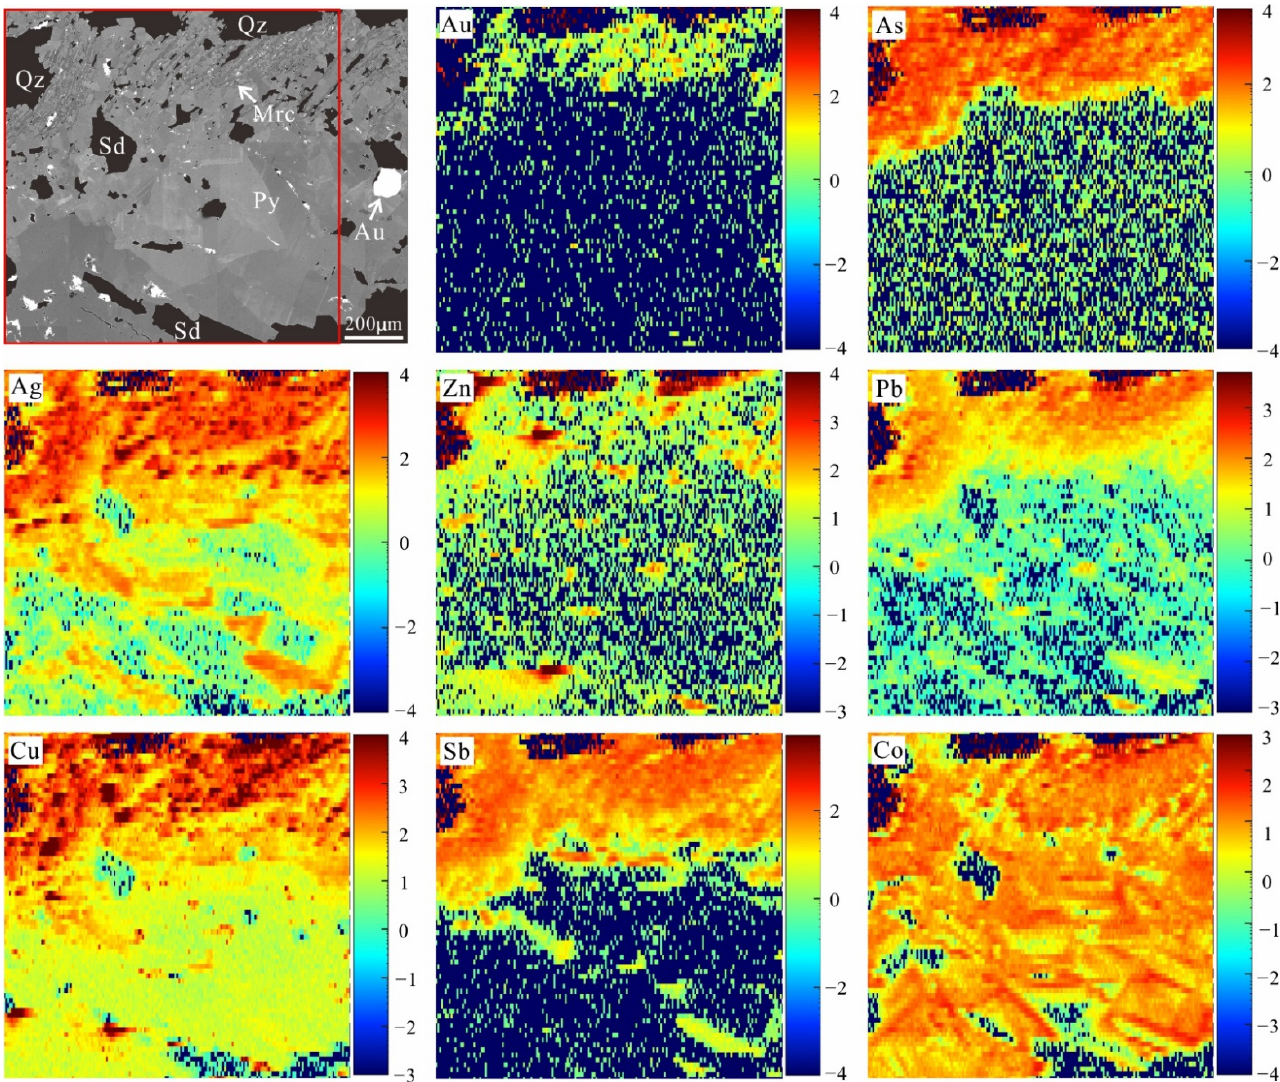
Figure 9. BSE image of pyrite and marcasite and the distributions of selected trace elements obtained by LA–ICP–MS. The semi-quantitative concentrations of the elements were logarithmized.